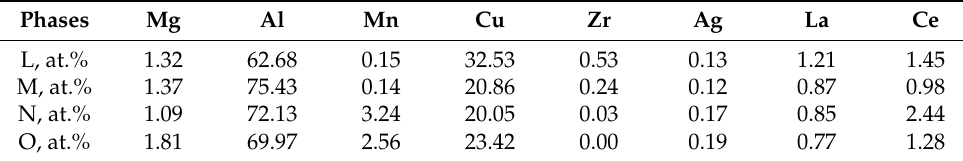
Table 2. Chemical composition of marked phases in homogenized alloys.